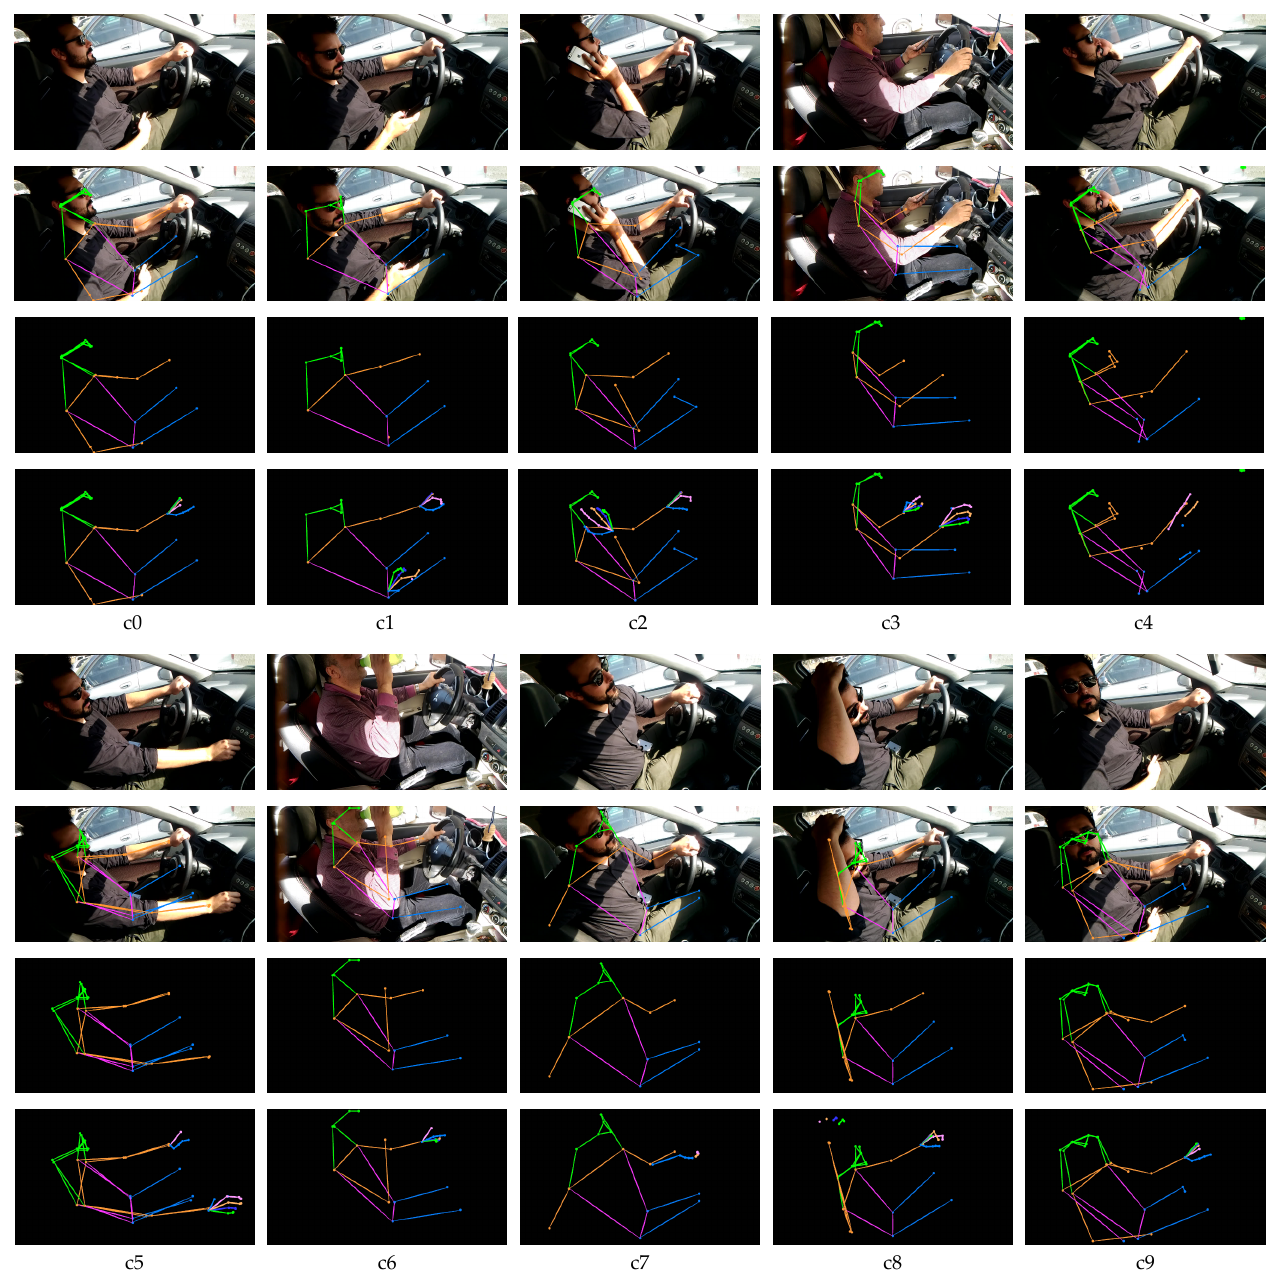
Figure 4. Input images for model training. The first row represents the original image from the dataset. The second row represents the image undergone pose estimation and overlays on top of the original image. The third row represents the pose sticks of the pose estimation. Forth row represents the pose and hand sticks of both pose and hand